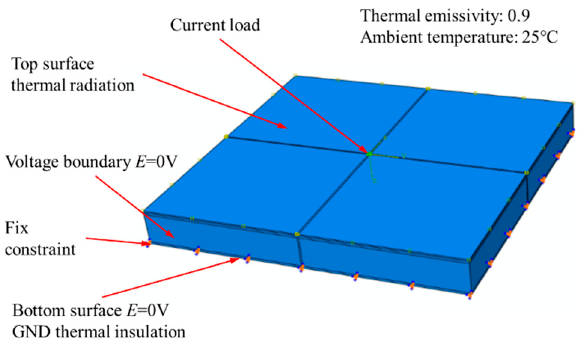
Figure 2. Boundary conditions and loading diagrams. Table 3. CYCOM 970 / PWC thermal and electrical material properties vs. temperature.